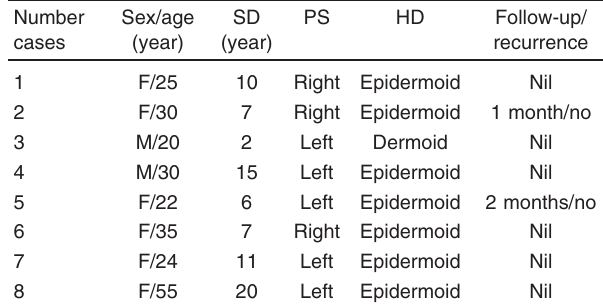
Table 1 Distribution of clinical characteristics of adults ’ with postauricular